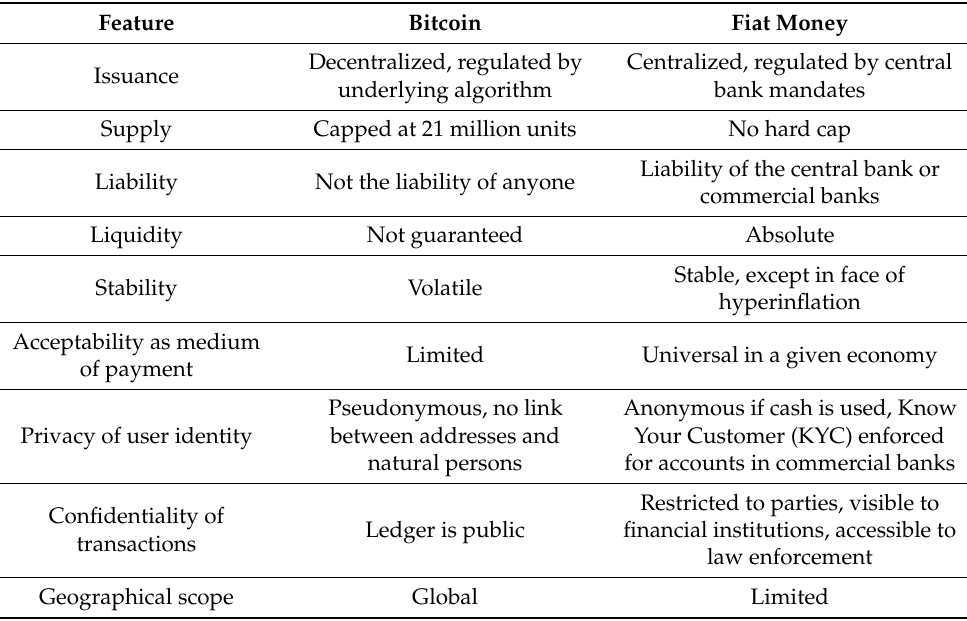
Table 1. Broad comparison between Bitcoin and traditional fiat money; source: